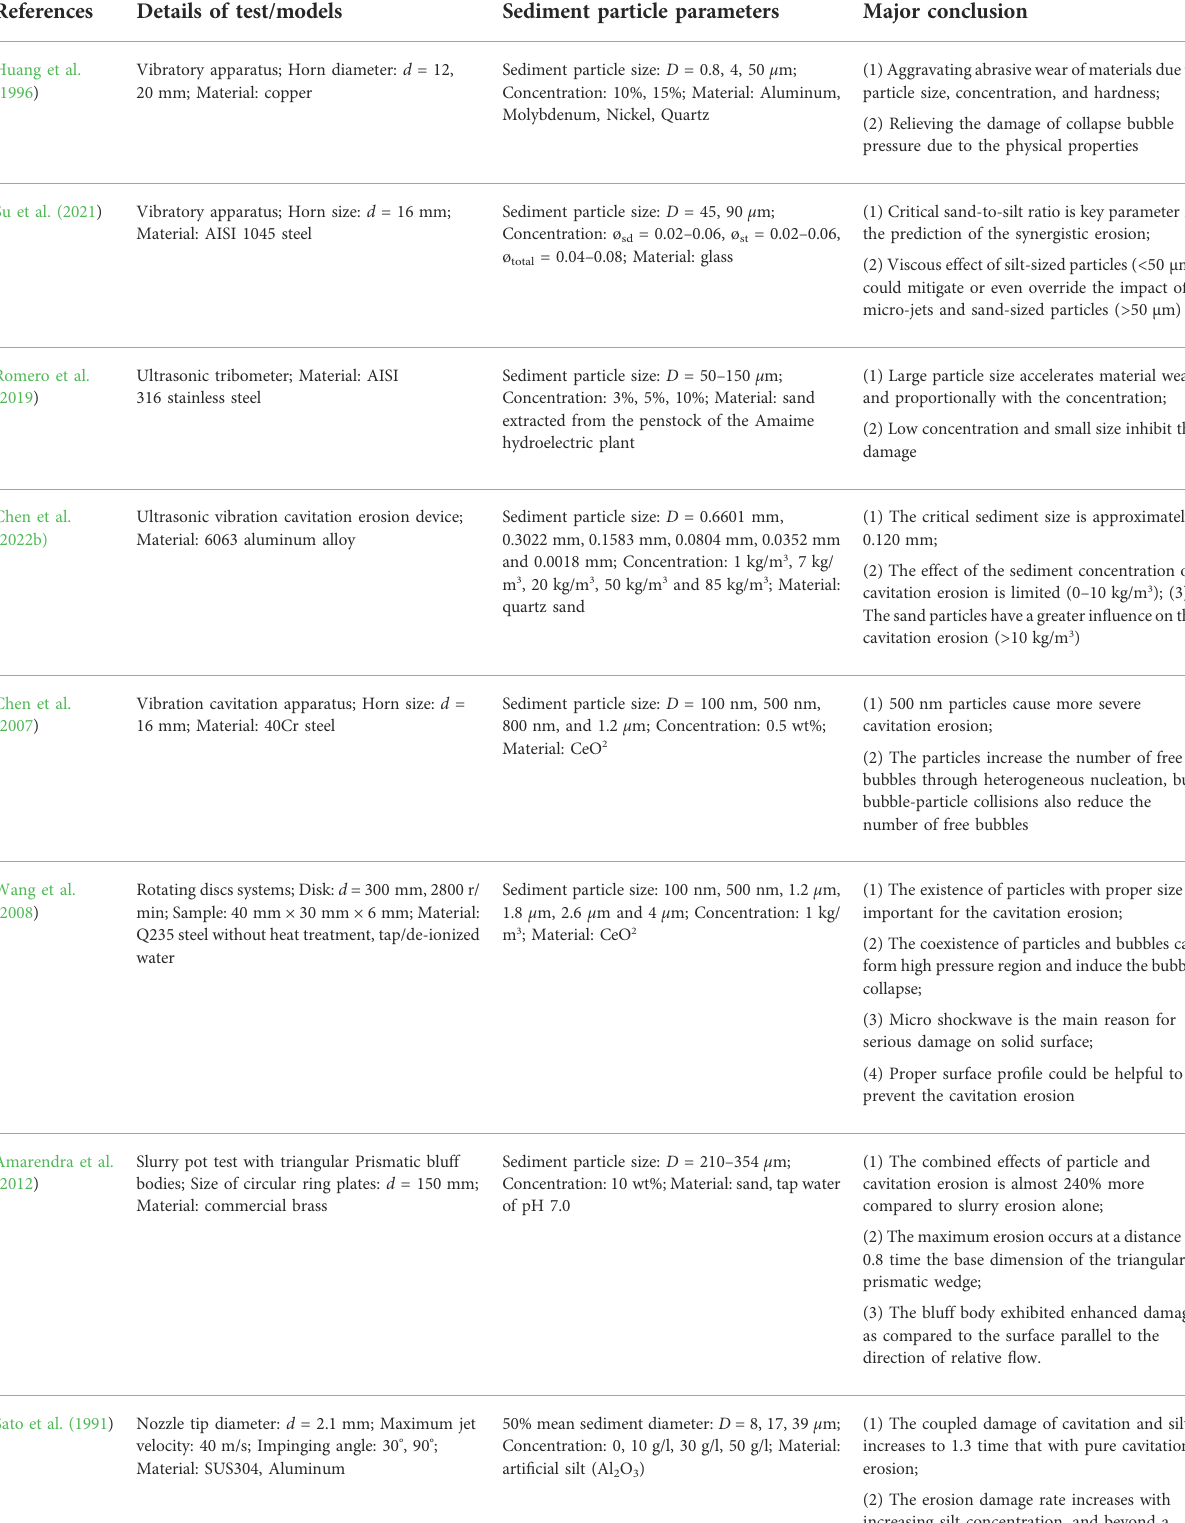
TABLE 1 Main experimental studies on synergy of cavitation and sediment